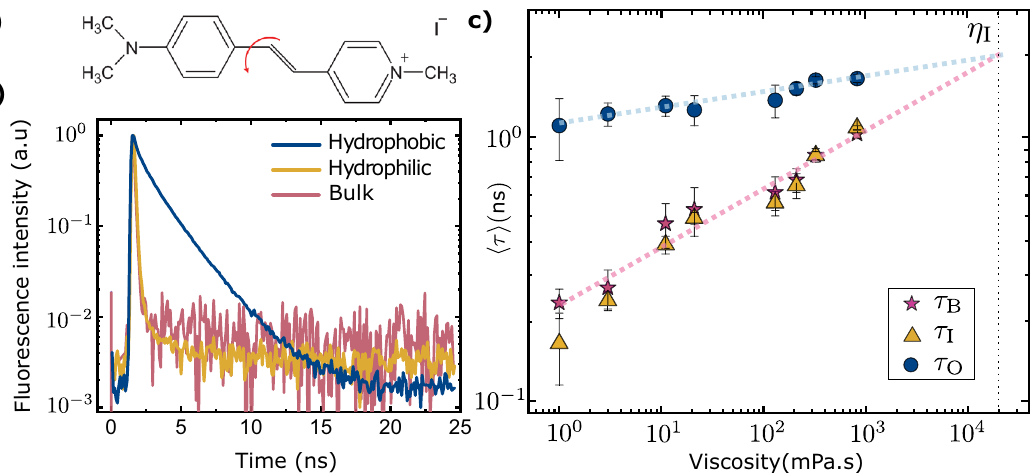
Figure 1. Fluorescence decays of 4-daspi reveal an adsorbed layer on hydrophobic glass Fluorescence of 4-daspi in glycerol/water solutions. ( a ) Structure of the molecular rotor 4-daspi. The red arrow indicates the intramolecular rotation; ( b ) Decays in water in the bulk (red) and at a hydrophilic interface (yellow) are identical. The longer decay at a hydrophobic interface (blue) shows up an additional, physisorbed species; ( c ) Amplitude averaged lifetime of 4-daspi as a function of glycerol/water viscosity. Hydrophobic glass: τ O , bullets; hydrophilic glass: τ I , triangles; bulk for the reference measurements: τ B , stars. Error bars indicated the standard deviation for different samples. The dashed lines are Förster-Hoffman equation fitted to data points of bulk solutions and hydrophobic